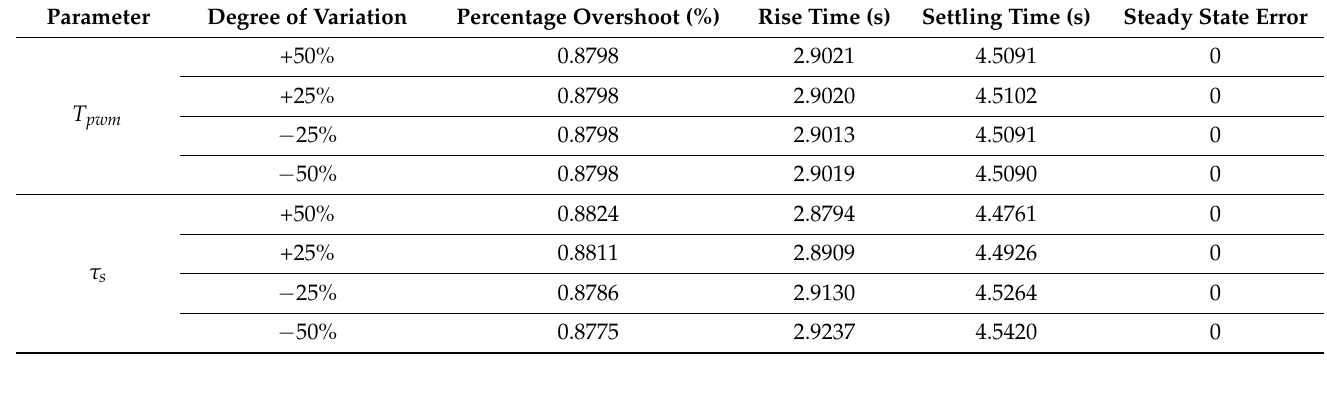
Figure 41. Wind variation effect on BEV performances.